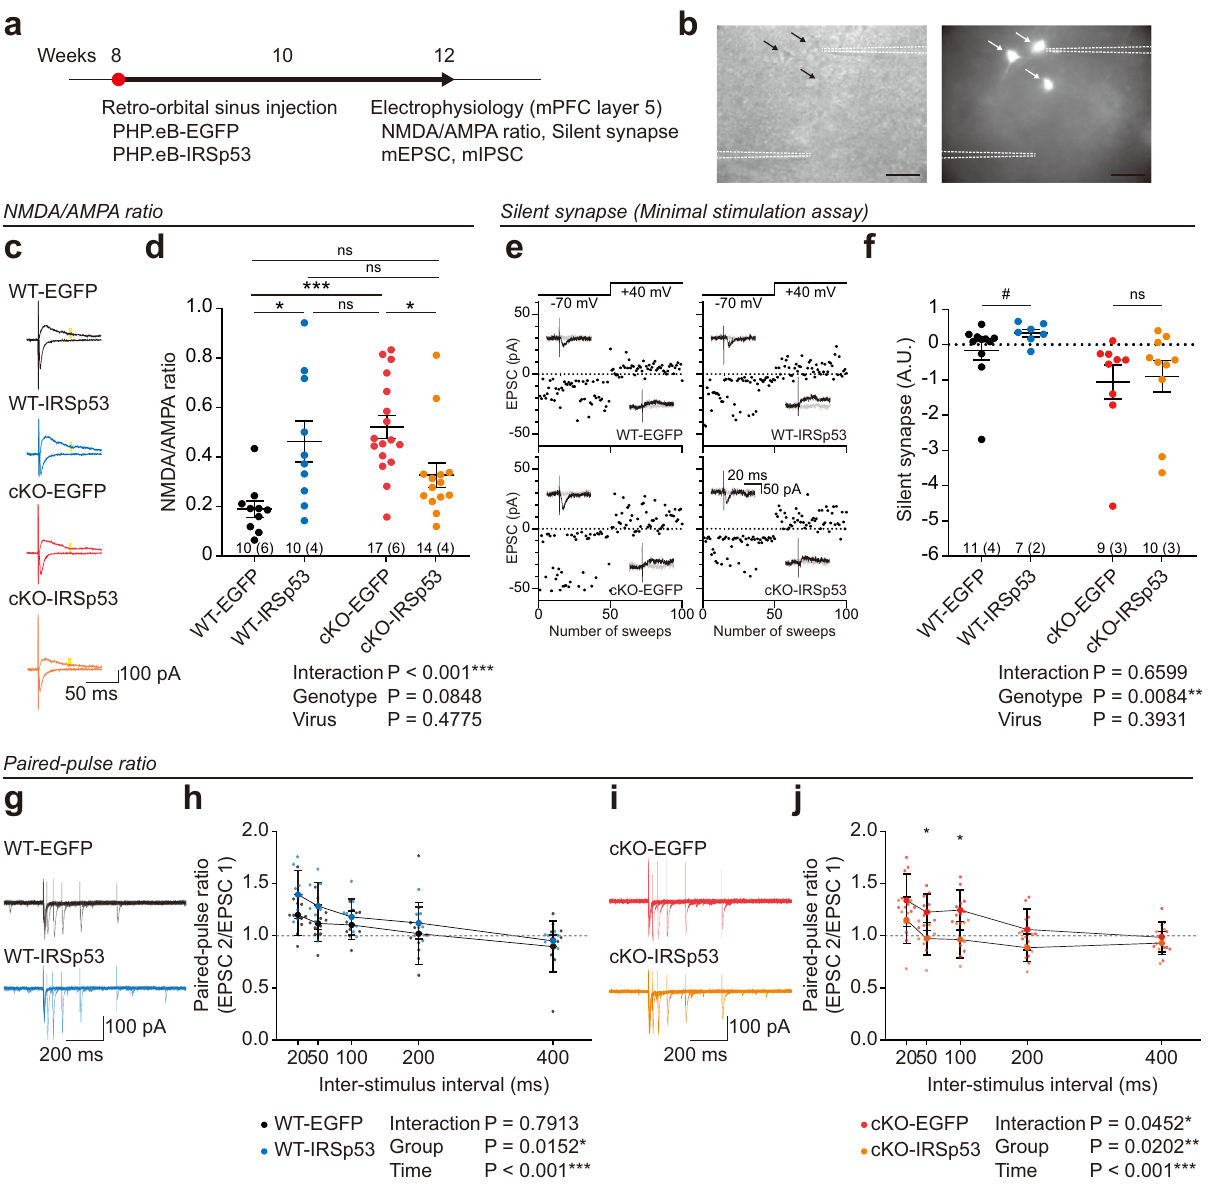
Fig. 4 Adult IRSp53 re-expression rescues NMDA/AMPA ratios in IRSp53-cKO cortical neurons. a Experimental scheme showing injection of PHP.eB- IRSp53 or control (PHP.eB-EGFP) into the retro-orbital sinus of WT or IRSp53-cKO mice at postnatal week 8 and electrophysiological measurements (evoked and miniature EPSCs) at postnatal week ~12. b Examples of layer 5 pyramidal neurons in the prelimbic region of the mPFC, where NMDAR/ AMPAR-EPSCs or mEPSCs were measured, from WT mice injected with PHP.eB-EGFP into the retro-orbital sinus at postnatal week 8 and visualized under fl uorescence microscopy at postnatal week 12 without additional EGFP staining. The EGFP signals in the neurons were enhanced to clearly indicate the neurons analyzed by patch-clamp recordings. c Sample traces of evoked NMDAR- and AMPAR-EPSCs from EGFP/IRSp53-expressing WT/IRSp53-cKO mice. d PHP.eB-IRSp53 injection normalizes the ratio of NMDAR-EPSCs and AMPAR-EPSCs in mPFC layer 5 pyramidal neurons of adult IRSp53-cKO mice. Note that IRSp53 overexpression in WT mice increases the NMDA/AMPA ratio ( n = 10 neurons from 6 mice [WT-EGFP], 10, 4 [WT-IRSp53],17, 6 [IRSp53-cKO-EGFP], and 14, 4 [IRSp53-cKO-IRSp53], two-way ANOVA with Sidak ’ s test). e , f IRSp53 overexpression in WT neurons increases silent synapses, whereas IRSp53-re-expression in IRSp53-cKO neurons does not affect silent synapses ( n = 11, 4 [WT-EGFP], 7, 2 [WT-IRSp53], 9, 3 [IRSp53- cKO-EGFP], and 10, 3 [IRSp53-cKO-IRSp53], two-way ANOVA with Sidak ’ s test, #p < 0.05 [Mann-Whitney test]). g , h Increased paired-pulse facilitation (PPF) in IRSp53-overexpressing WT mPFC layer 5 pyramidal neurons. WT mice were infected with PHP.eB-IRSp53, or PHP.eB-EGFP (control), at 8 weeks, and EGFP-positive neurons were used to measure PPF at 12 weeks ( n = 11, 2 [WT-EGFP], 8, 2 [WT-IRSp53], two-way ANOVA with Sidak ’ s test). i , j Decreased PPF in IRSp53-re-expressing IRSp53-cKO mPFC layer 5 pyramidal neurons. IRSp53-cKO mice (Emx1) were infected with PHP.eB-IRSp53, or PHP.eB-EGFP (control), at 8 weeks, and EGFP-positive neurons were used to measure PPF at 12 weeks ( n = 11, 2 [cKO-EGFP], 7, 2 [cKO-IRSp53], two-way ANOVA with Sidak ’ s test). Signi fi cance values are indicated as * p < 0.05, ** p < 0.01, *** p < 0.001, or ns (not signi fi cant, p > 0.05). Error bars represent the standard errors of